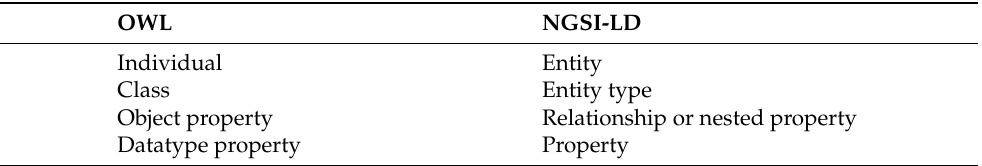
Table 3. OWL and NGSI-LD